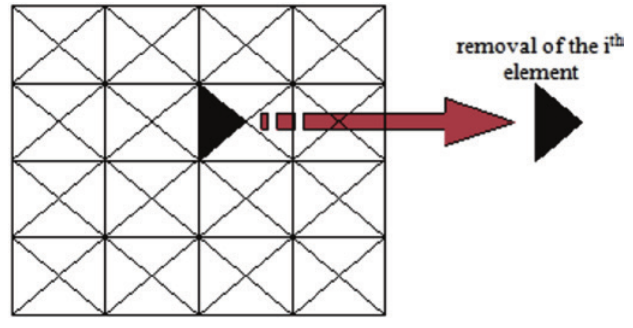
Removal of the element from mesh by the